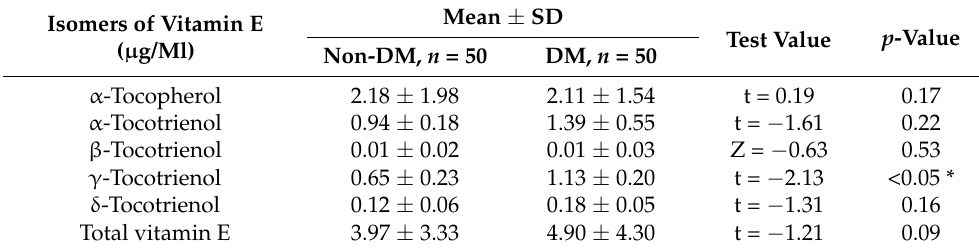
Table 7. Plasma vitamin E isomer levels in non-DM and DM groups.